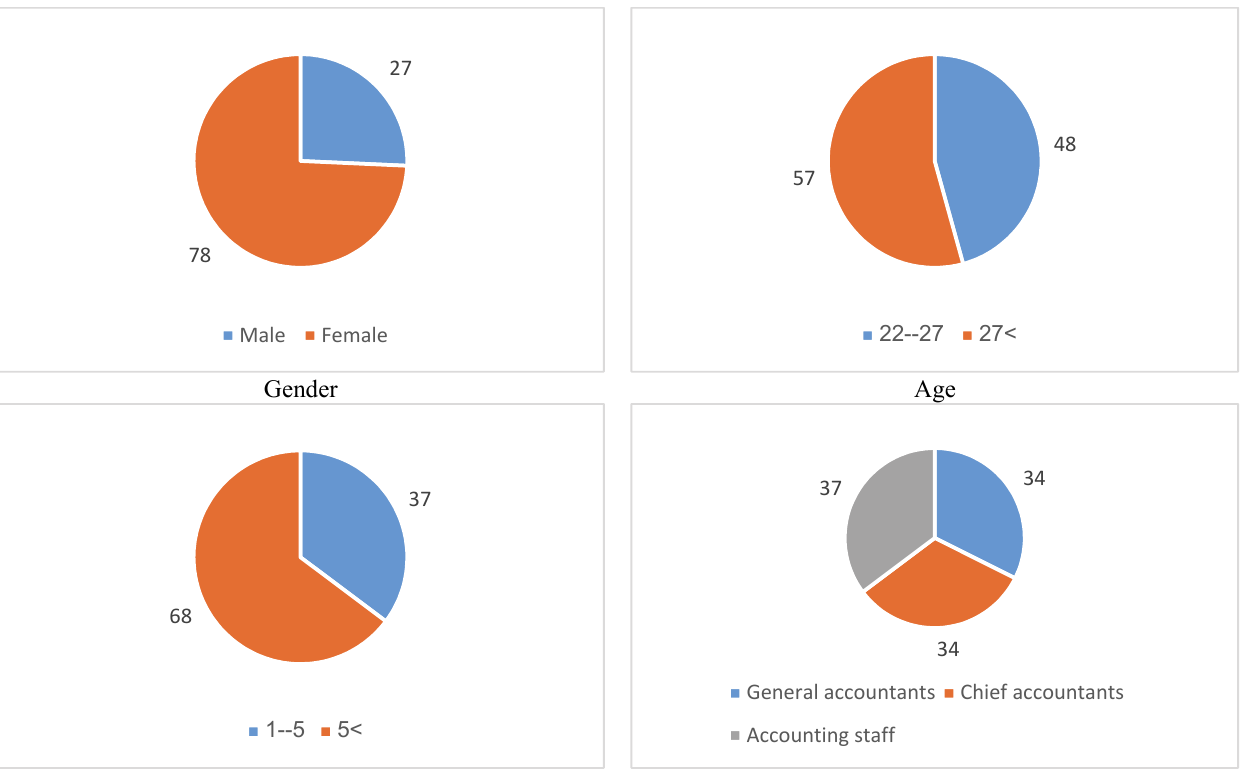
Fig. 2. Respondents by gender, age, job description, seniority